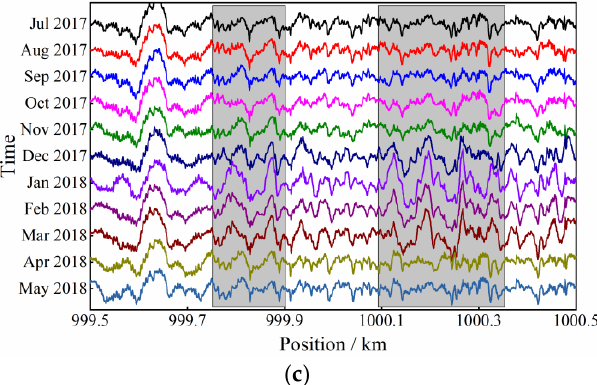
Figure 13. Evolution of differential substructure deformation: ( a ) pier deformation; ( b ) subgrade settlement; ( c ) frost-heave deformation of subgrade.